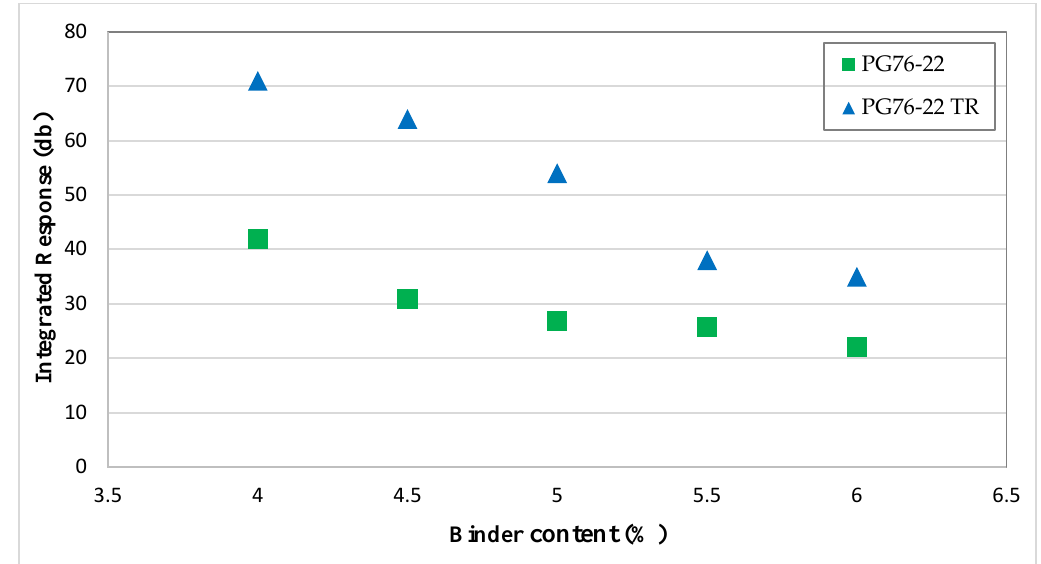
Figure 6. Wave integrated response trend with binder content for PG 76-22 mix.